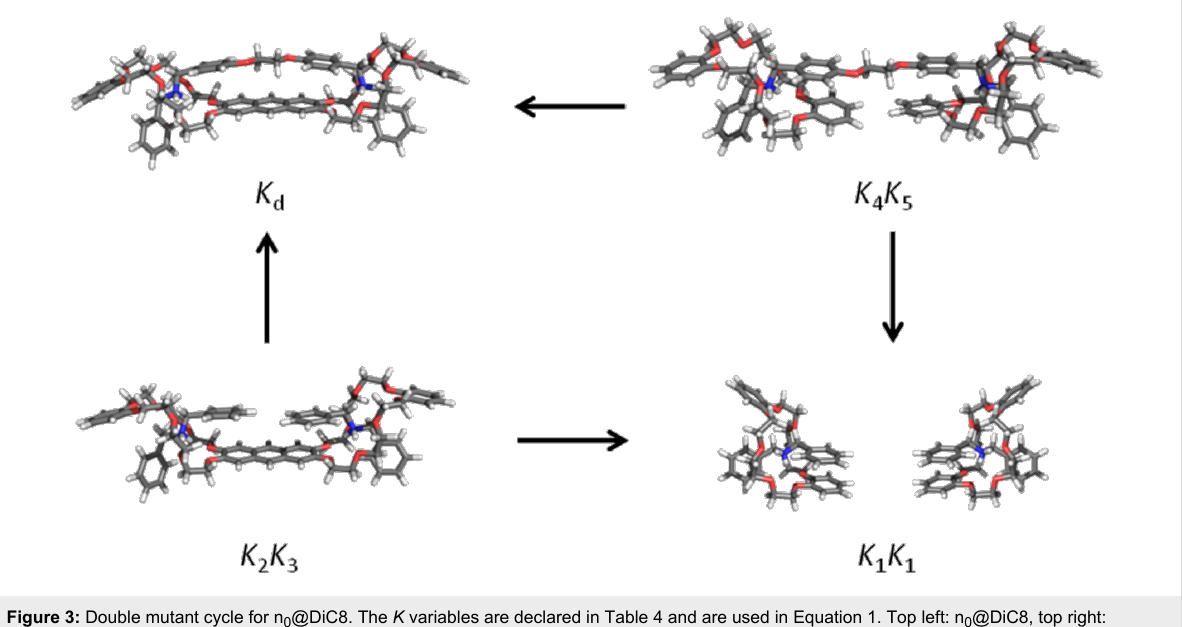
Figure 3: Double mutant cycle for n 0 @DiC8. The K variables are declared in Table 4 and are used in Equation 1. Top left: n 0 @DiC8, top right: n 0 @2C8, bottom left: 2Ph@DiC8 and bottom right: two Ph@C8. The figures show the optimized gas phase structures.